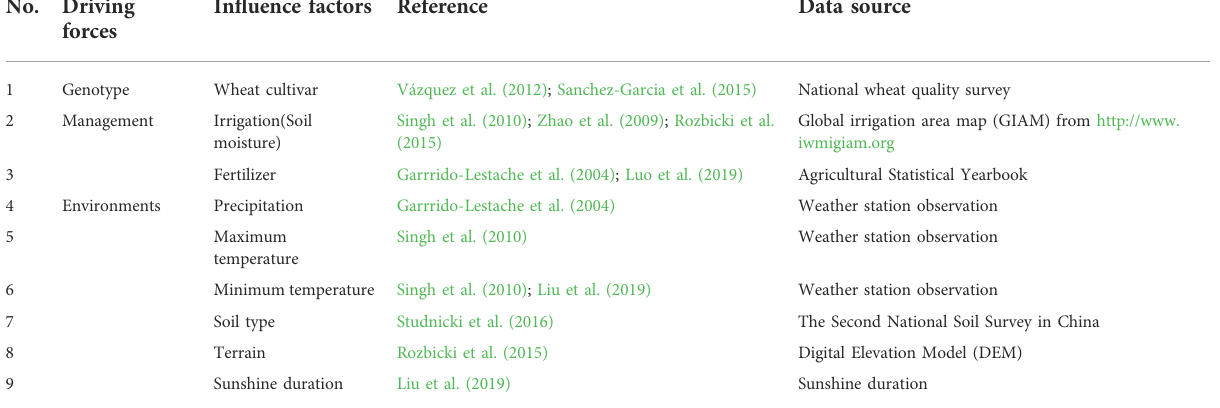
TABLE 2 Factors used to analyze the driving forces of wheat